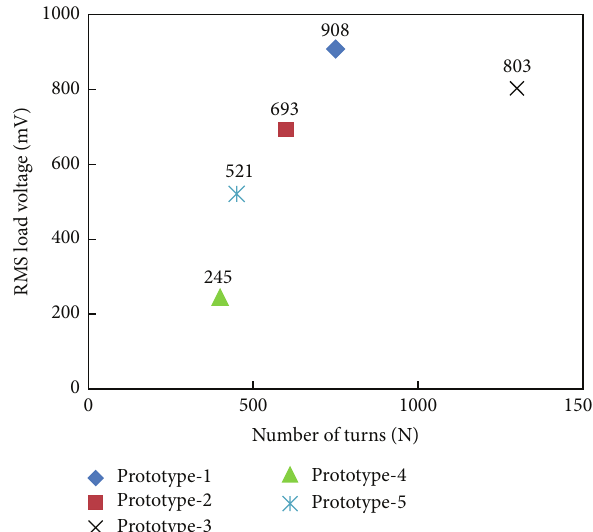
Figure 18: Induced load voltage in inductive energy harvesters as a function of number of coil turns at current level of 155 A.